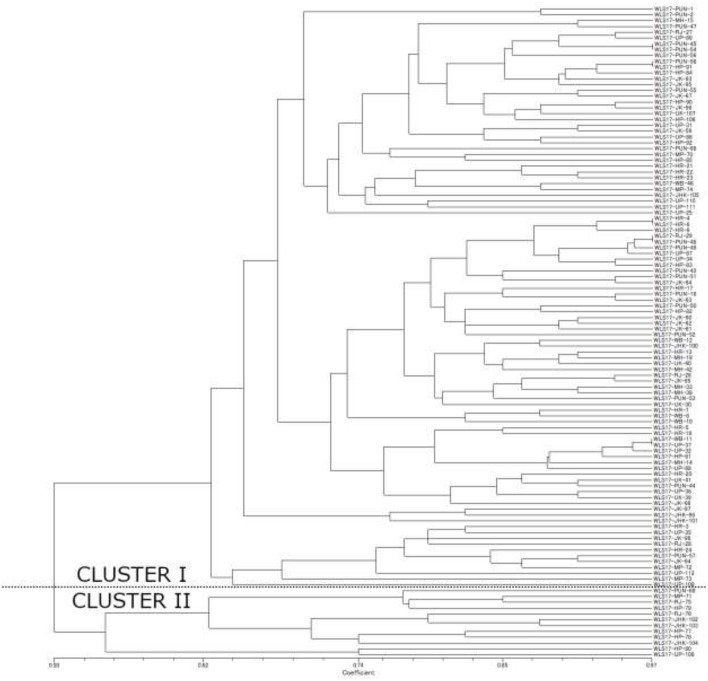
Unweighted Neighbor-joining tree using the simple matching similarity coefficient based on 16 microsatellite markers for the 112 isolates of UST isolated from wheat spikes in India.